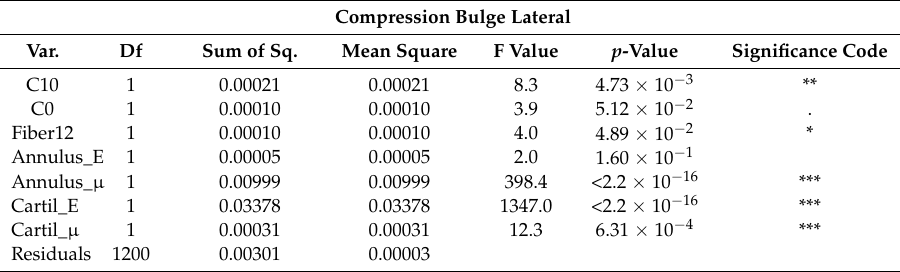
Table 12. ANOVA table for a compression bulge lateral linear model.